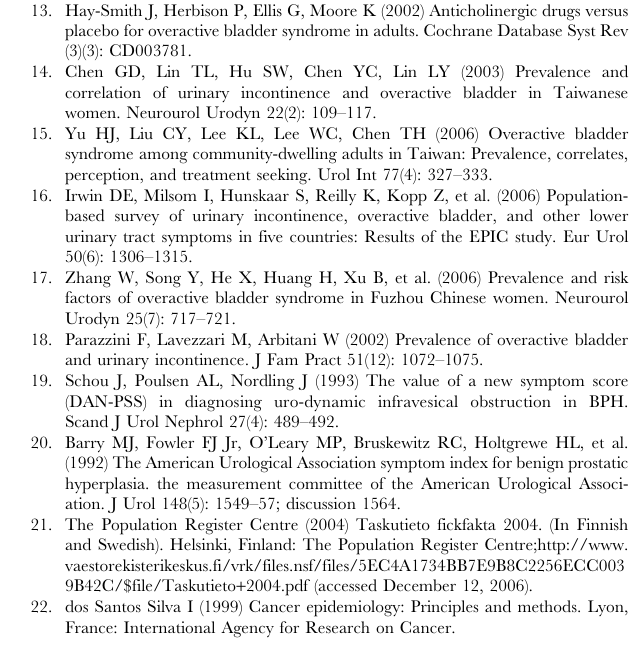
Table S1 Number of subjects in different analyses and in overactive bladder